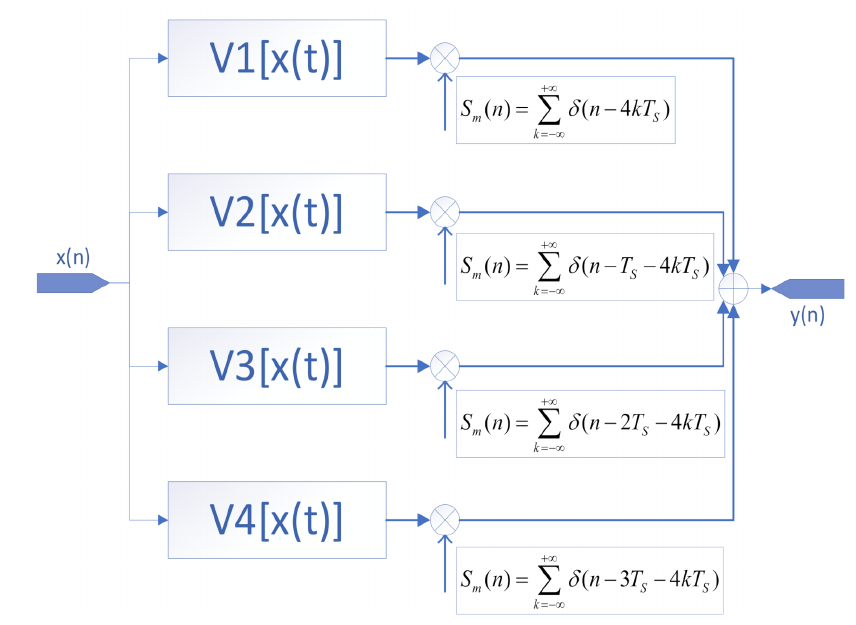
Figure 3. Three-order Volterra series model of the